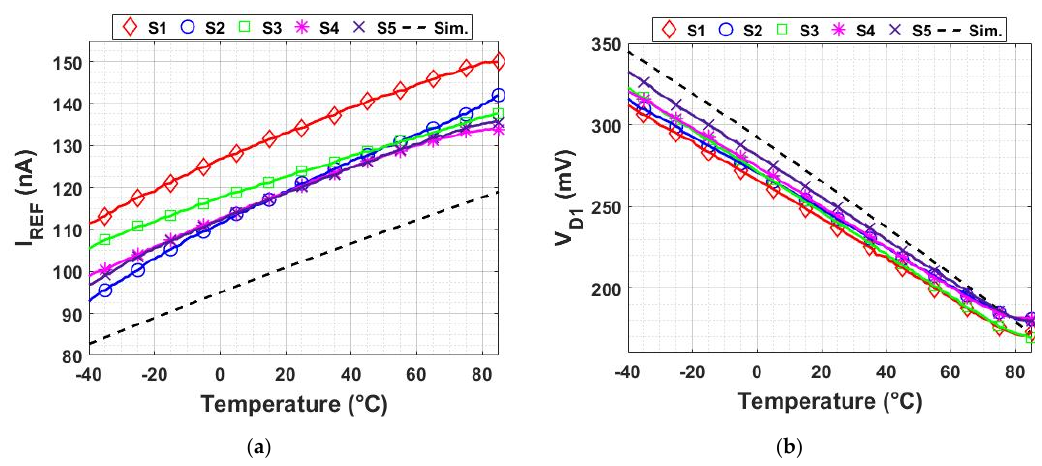
Figure 18. ( a ) The measured I REF and ( b ) the Schottky diode as a function of temperature.